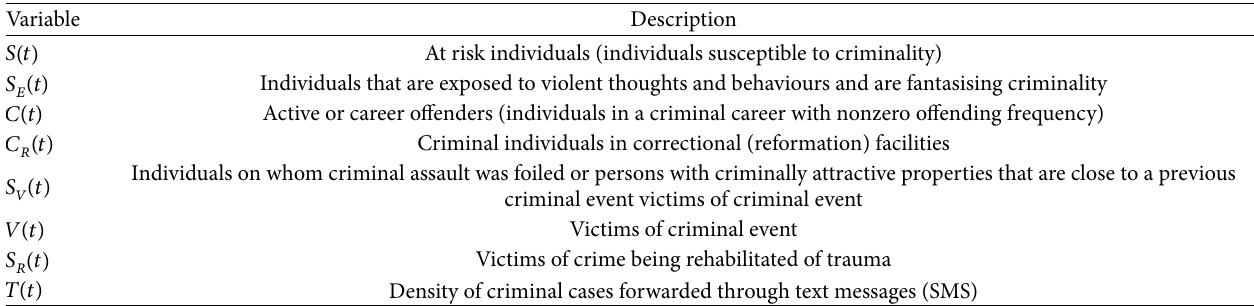
Table 1: Variables for the crime model and their